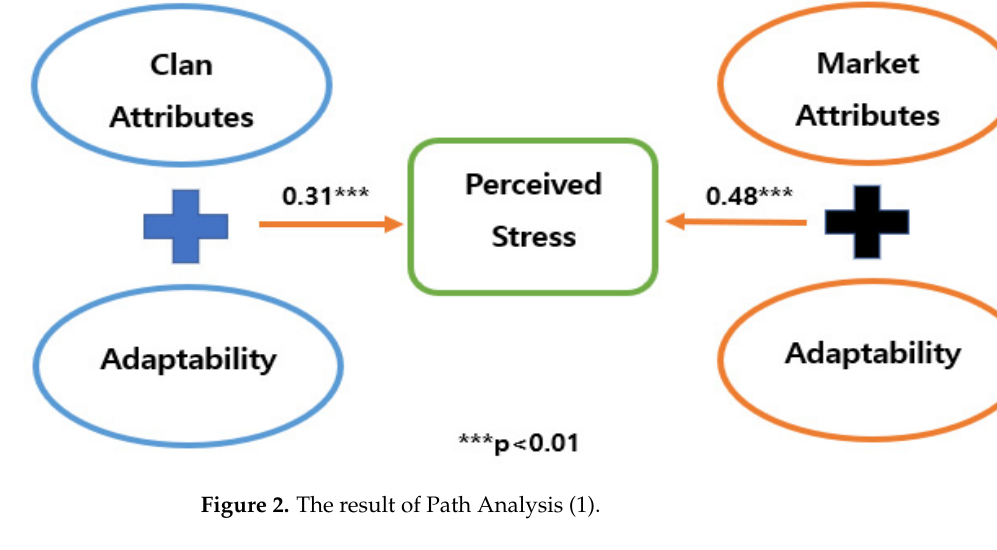
Figure 2. The result of Path Analysis (1).